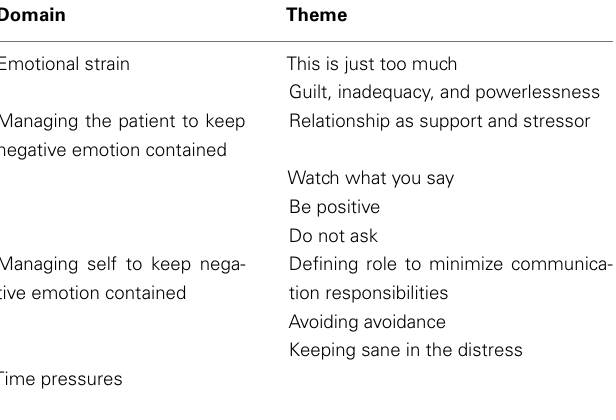
Table 2 | Summary of domains and